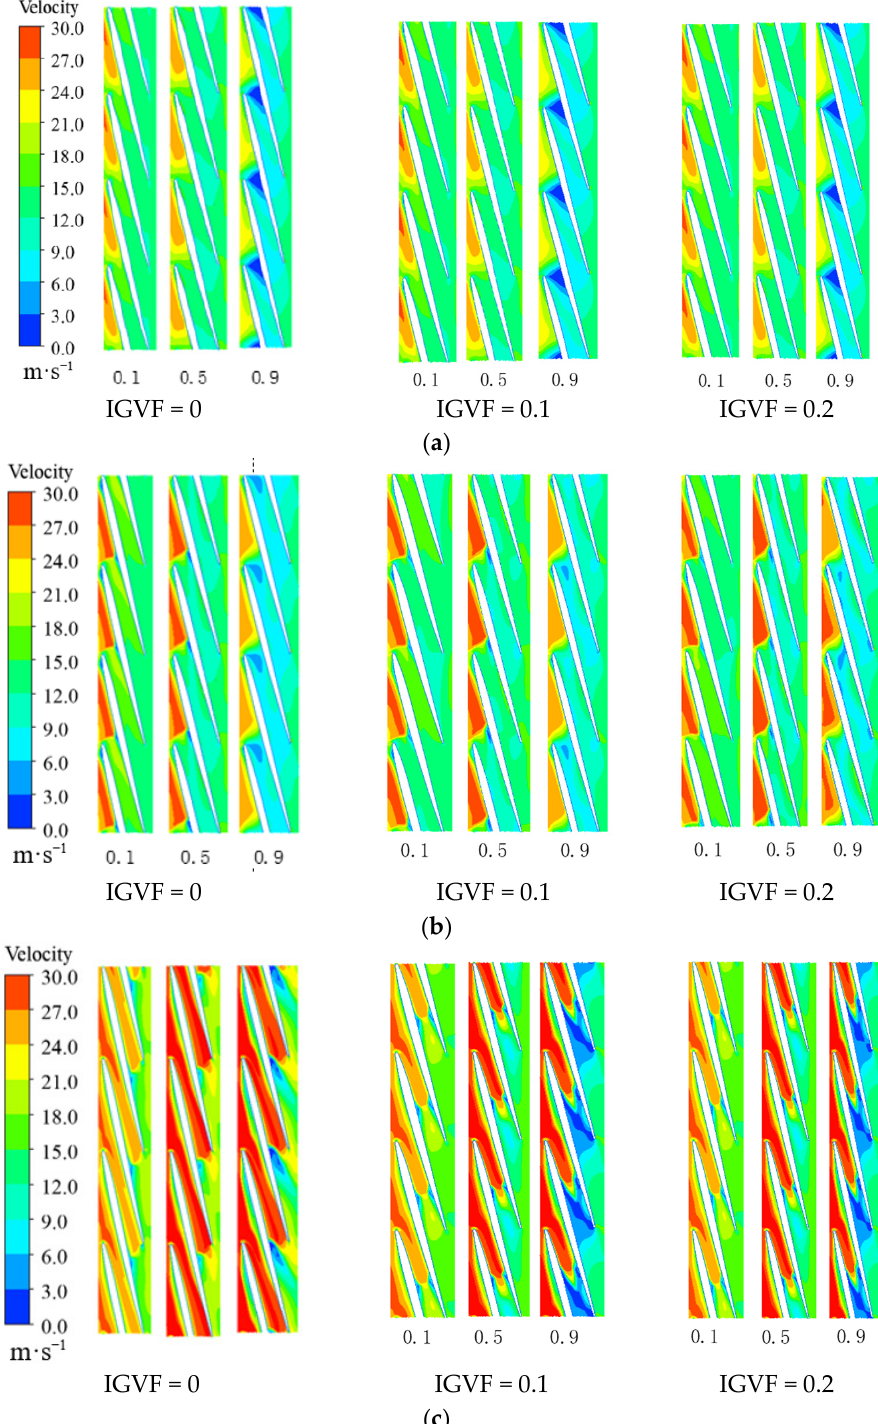
Figure 9. Velocity in impeller under IGVF = 0, 0.1 and 0.2. ( a ) Critical cavitation; ( b ) severe cavitation; and ( c ) fracture cavitation.